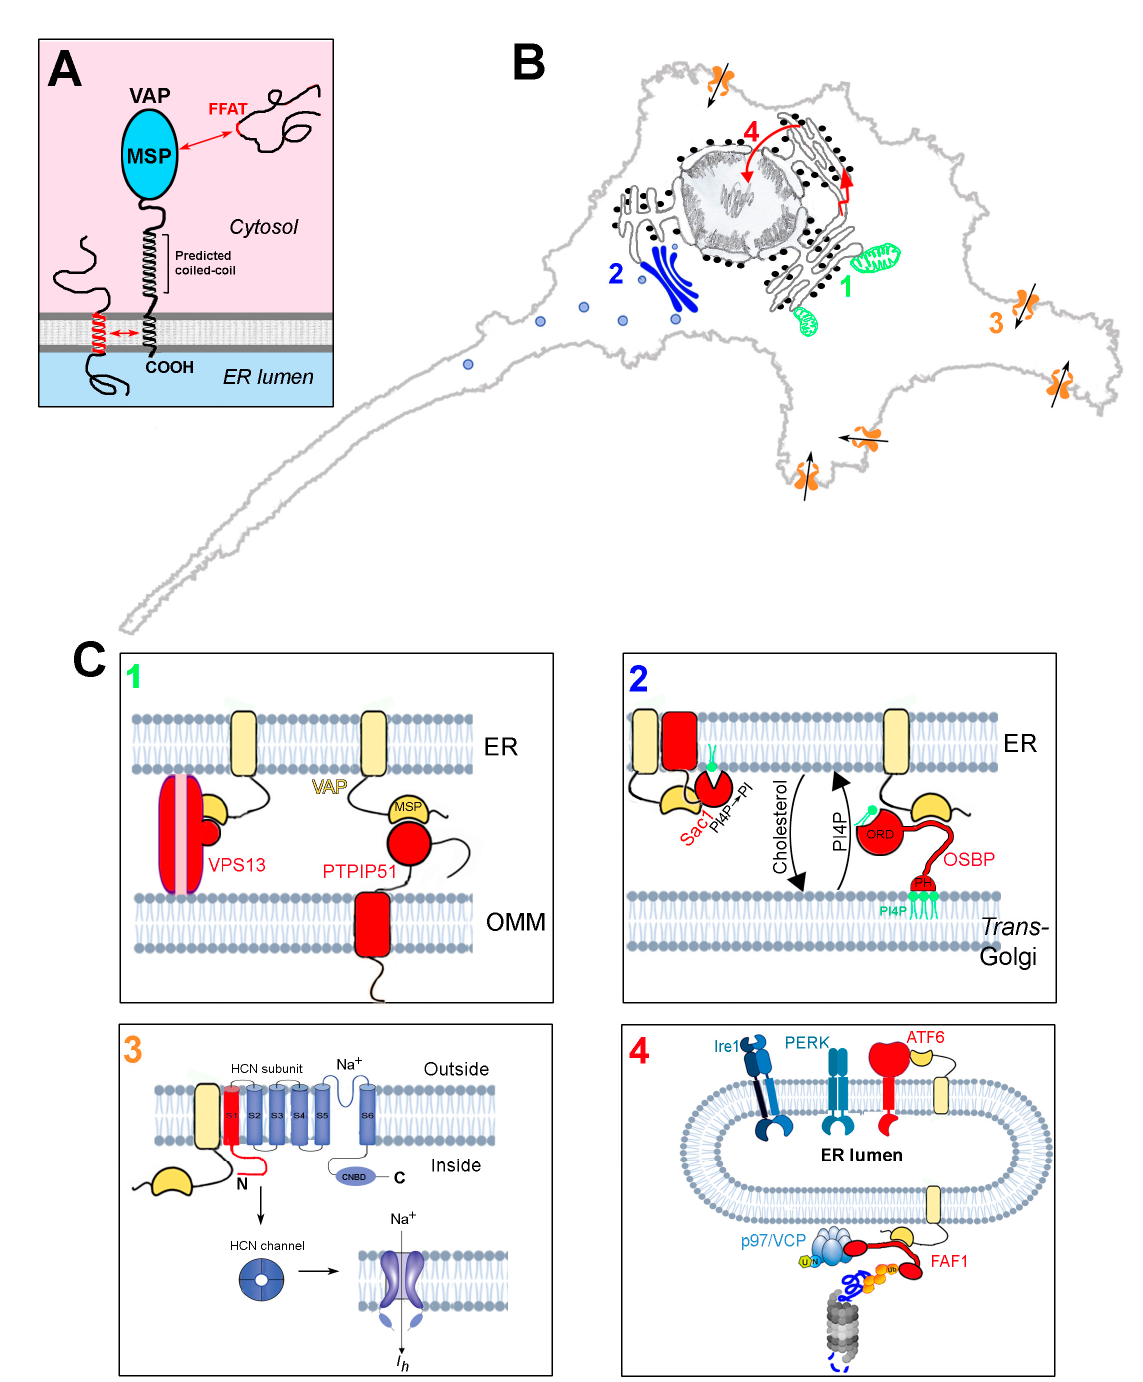
Figure 1. Structure and interactions of the VAP proteins. ( A ) Domain organisation and membrane topology of the VAPs. Interactions between FFAT motifs and the MSP domain, as well as those involving the TM helix, are indicated. ( B ) Schematic representation of four sites of action of the VAPs, involving processes that are perturbed by the deficit of the VAPB paralogue. Each of the four processes, and how they are affected by VAPB deficit, are discussed in Sections 4.1–4.4. 1: ER-mitochondria contact sites; 2: ER-Golgi contact sites; 3: regulation of HCN channels; 4: UPR and PQC. ( C ) Zoom-up images of sites 1–4 of panel ( B ), illustrating the underlying VAP interactions. For each site, the interacting proteins (or portions thereof) are shown in red. VAP is in yellow. Interactions between the MSP and FFAT motifs are indicated by complementary surfaces, which are purposely not drawn in cases where an FFAT motif is not involved in the interaction. VAP and PTPIP51 are redrawn from Ref. [34] and the FAF1 interactions (panel 4) are adapted from [35] (Creative Commons license). Phospholipid bilayers, UPR sensors, and the proteasome are adapted from Biorender